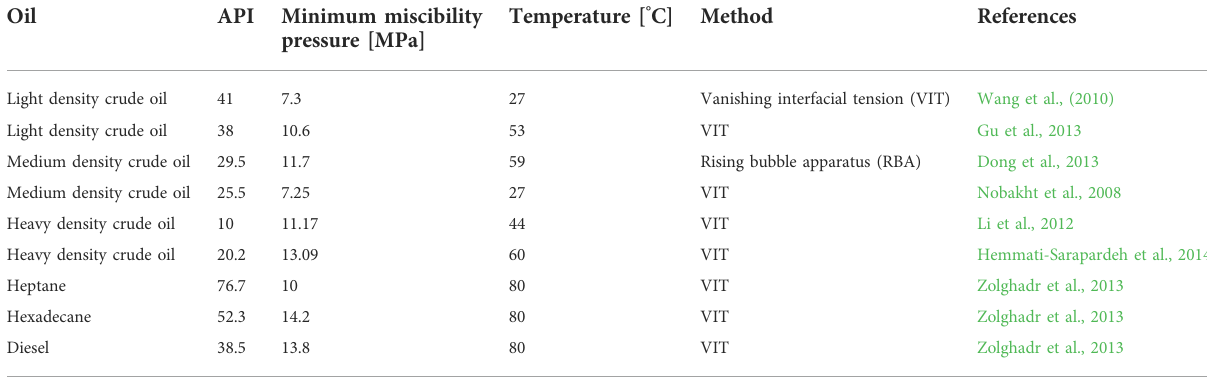
TABLE 3 Minimum miscibility pressure for different crude oils and organic